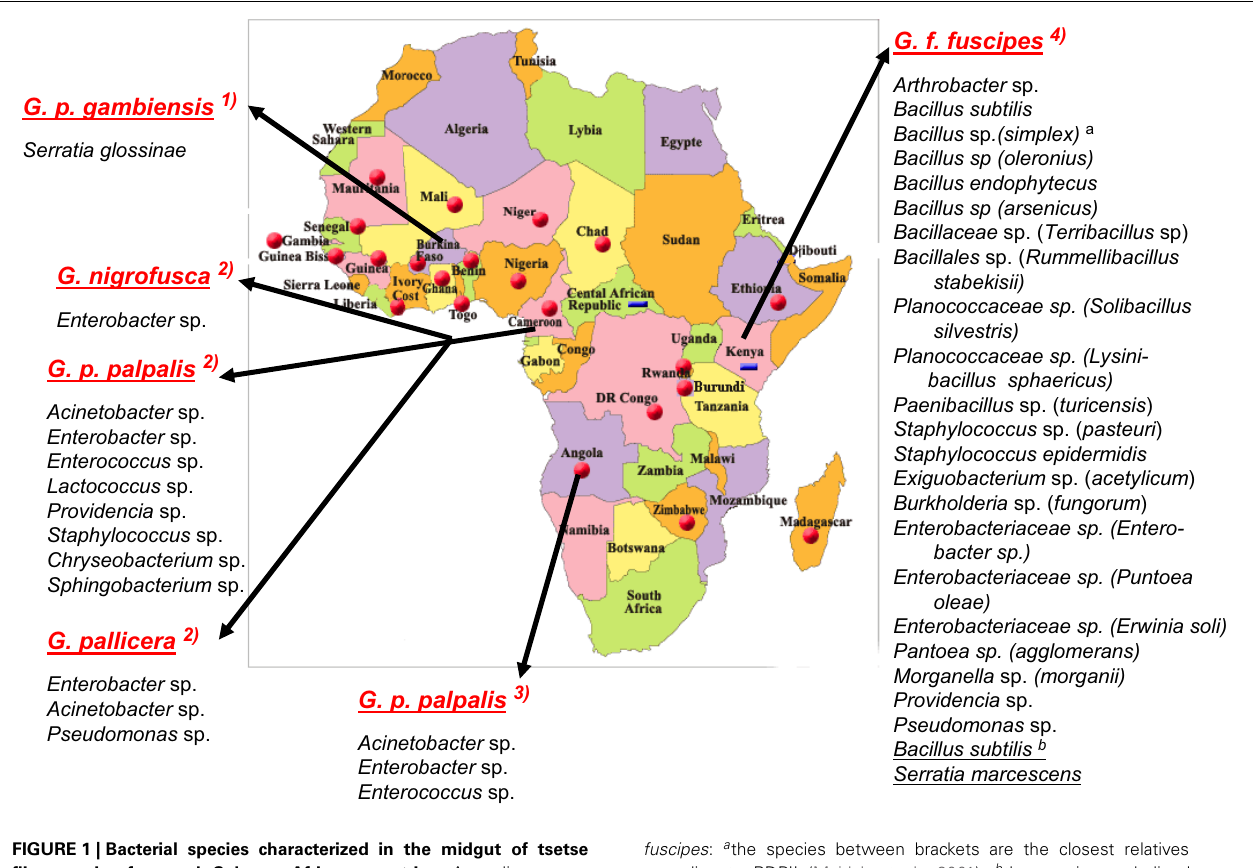
fuscipes : a the species between brackets are the closest relatives according to RDPII (Maidak et al., 2001); b the species underlined were identified with culture-independent methods. No bacteria were identified in G. caliginea